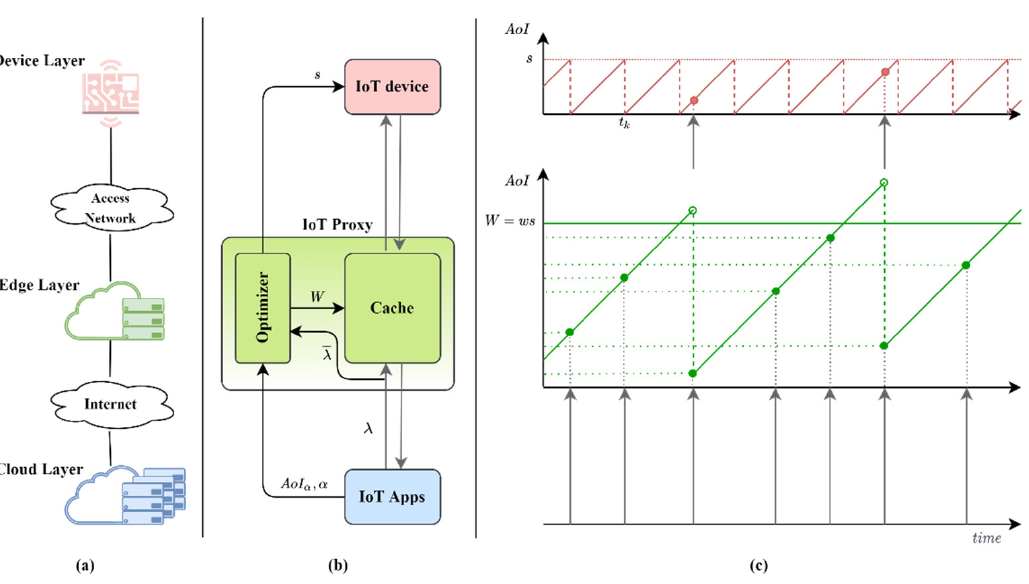
Figure 1. IoT system overview and model: ( a ) a typical IoT system, ( b ) the considered scenario, ( c ) the interplay over time between the arrival process of IoT-application requests, the sampling process, and the cache operations.